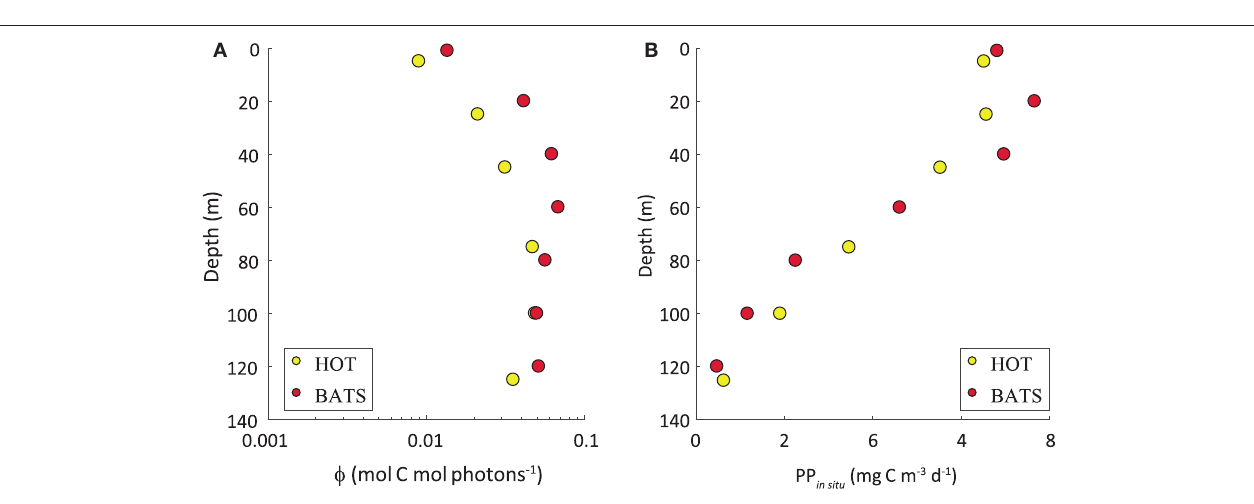
FIGURE 4 | (A) Annual average of the quantum yield of photosynthesis ( φ , in mol C mol photons − 1 ) in a vertical scale. The abscissa axis represents φ exhibited in log-scale (mol C mol photons − 1 ) and the ordinate axis shows depth (in m). (B) PP in situ (mg C m − 3 d − 1 ) along the water column. In both graphs, yellow dots represent HOT and red dots,